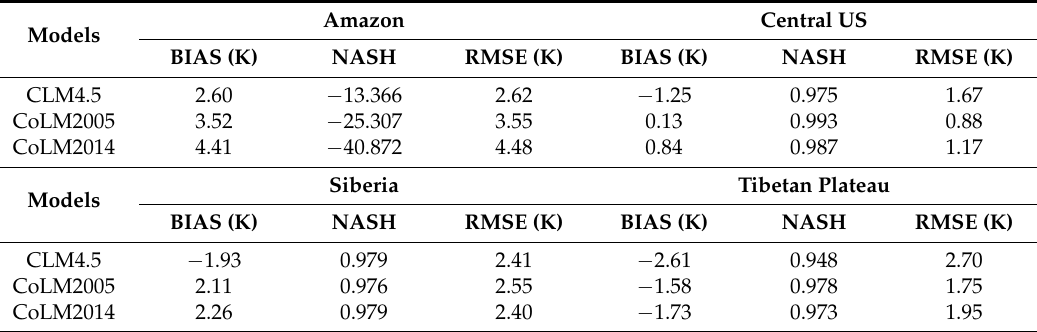
Table 7. Statistical summary of simulated land surface temperature annual cycles.